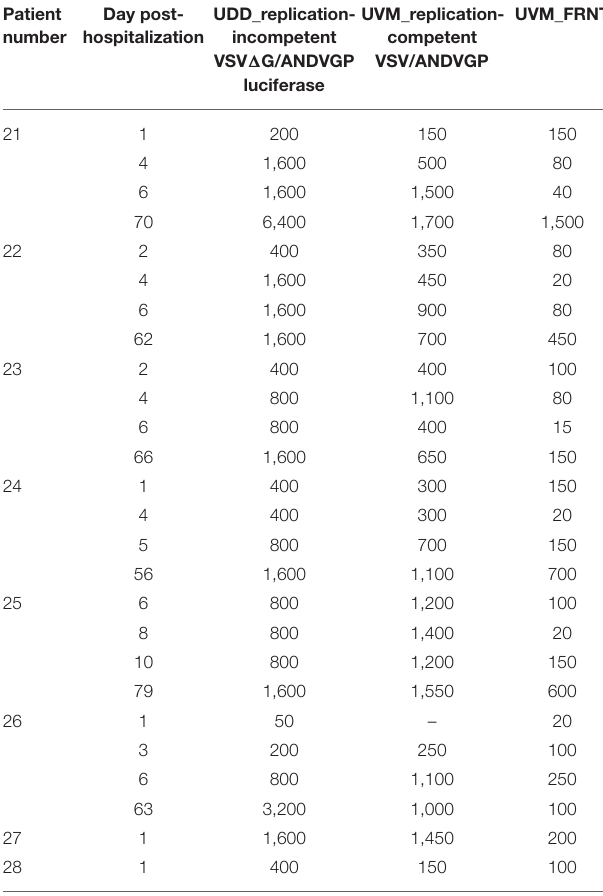
TABLE 2 | Kinetics of NAb formation in ANDV patients as measured by standard FRNT or ANDV GP-decorated VSV pseudoviruses (single-round